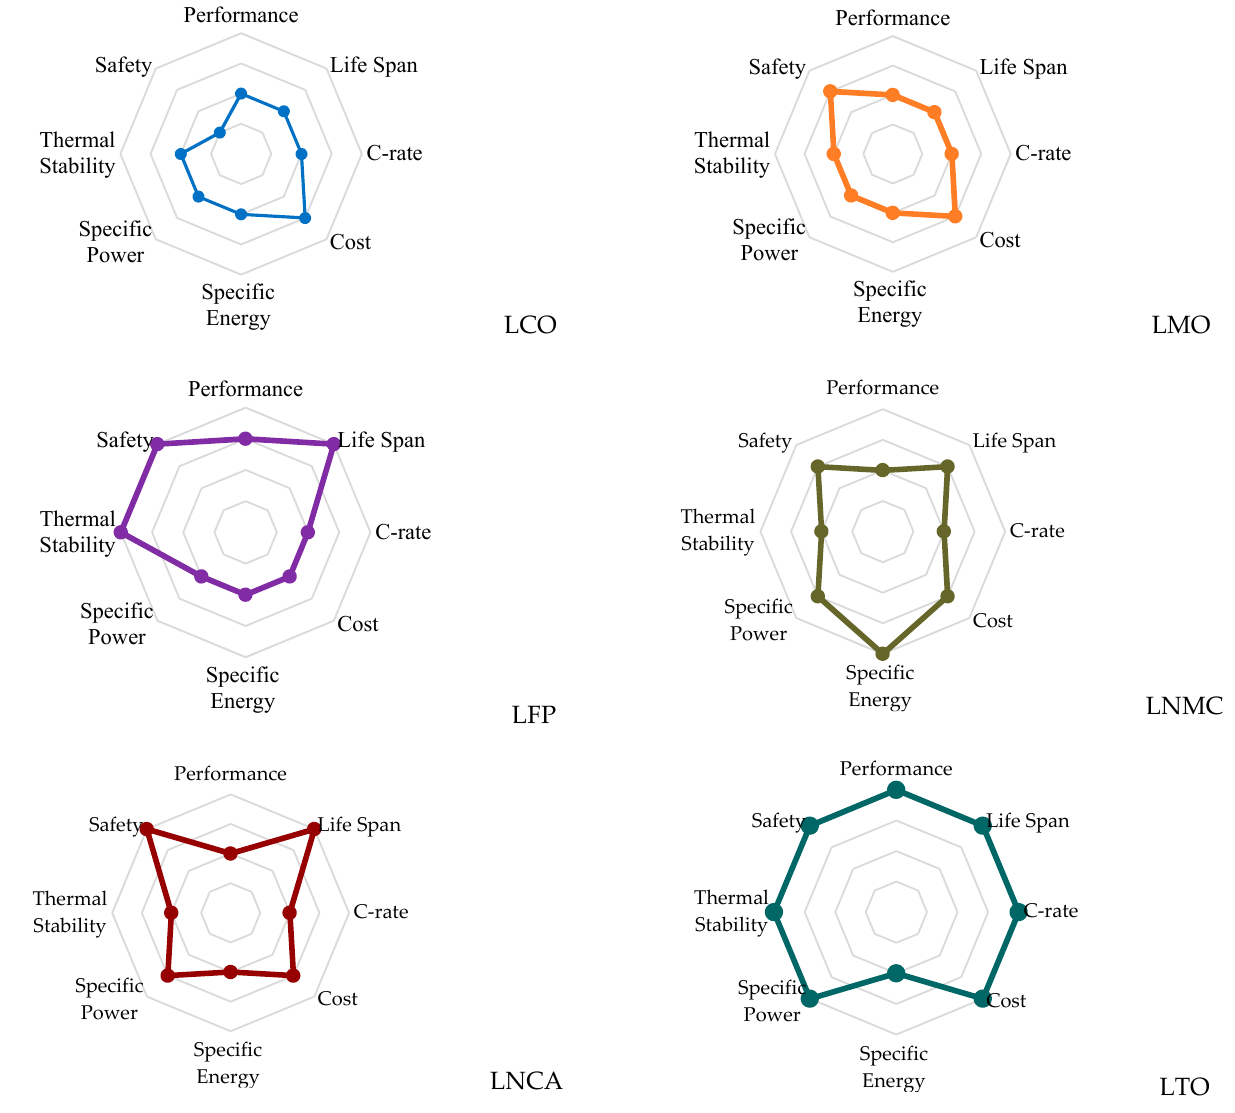
Figure 1. Performance comparison of different lithium-ion batteries according to indexed values.